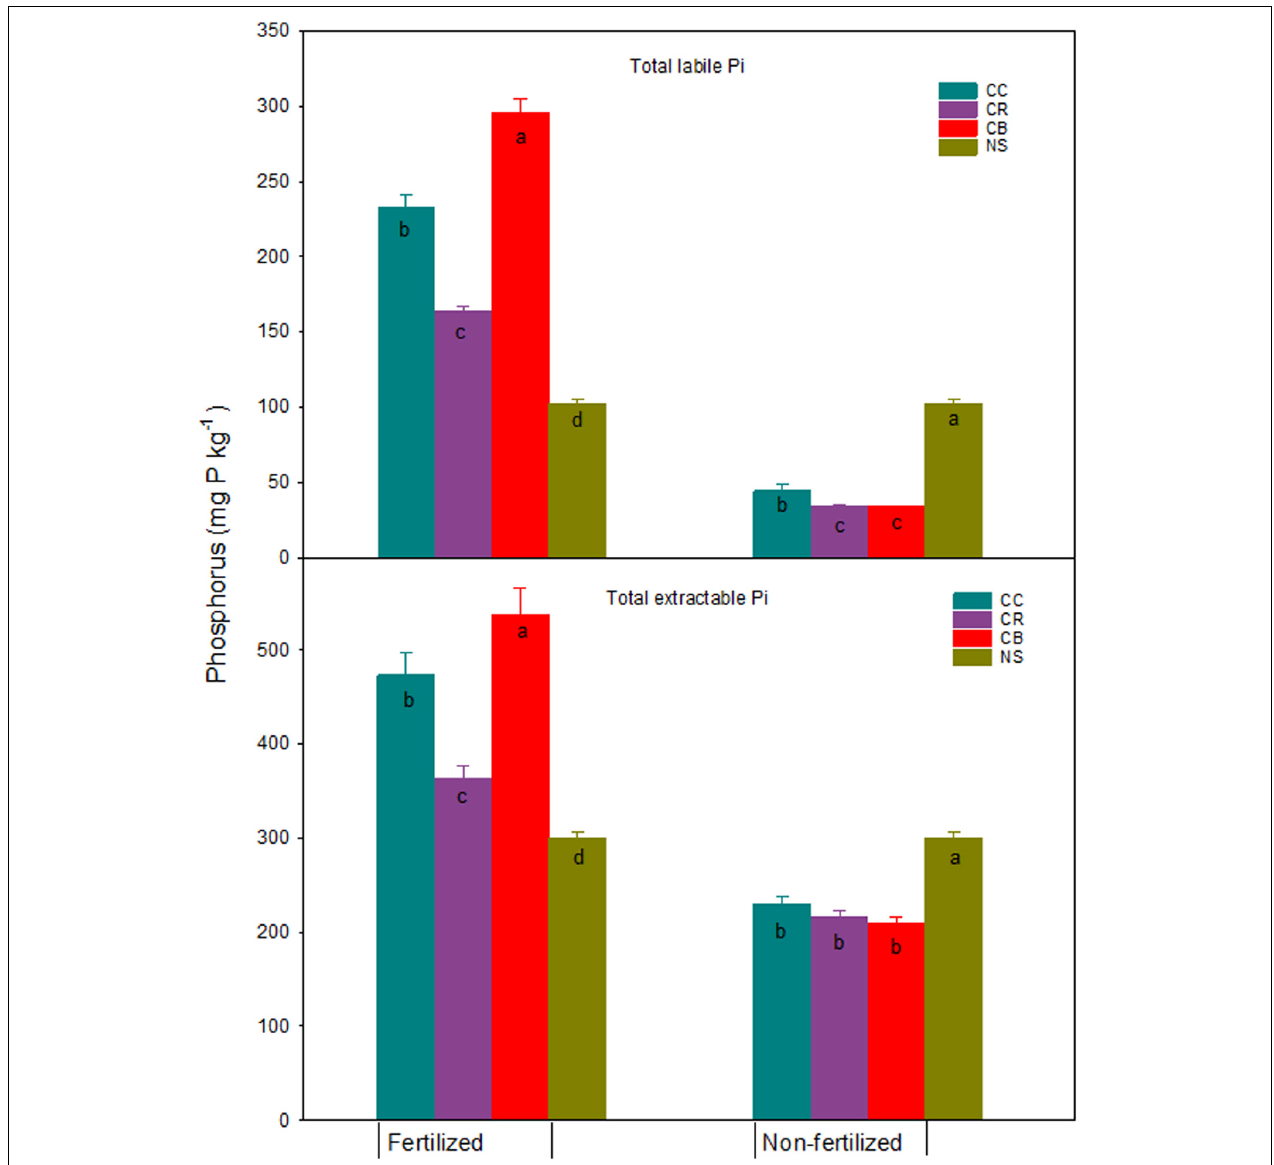
FIGURE 3 | Total extractable P i and labile P i and standard errors ( n = 3) (mg kg − 1 ) in a Brookston clay loam at Woodslee, ON, Canada, after 45-year consistent cropping with and without P fertilization relative to its native forest soil (NS). CC, continuous corn; CB, continuous bluegrass sod; CR, corn-oats-alfalfa-alfalfa rotation. Letters in the bars are significant levels (at P ≤ 0.05) with LSD test conducted separately for the fertilized and non-fertilized